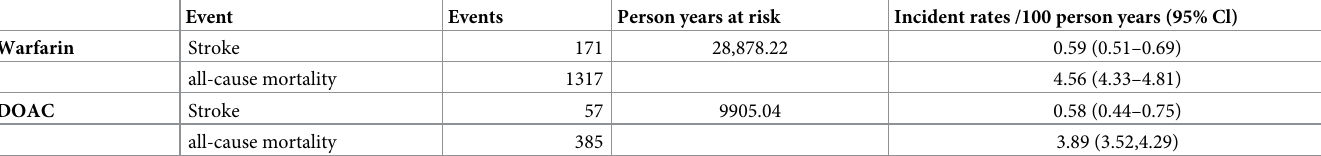
Table 2. Crude incidence rates of stroke and all-cause mortality.